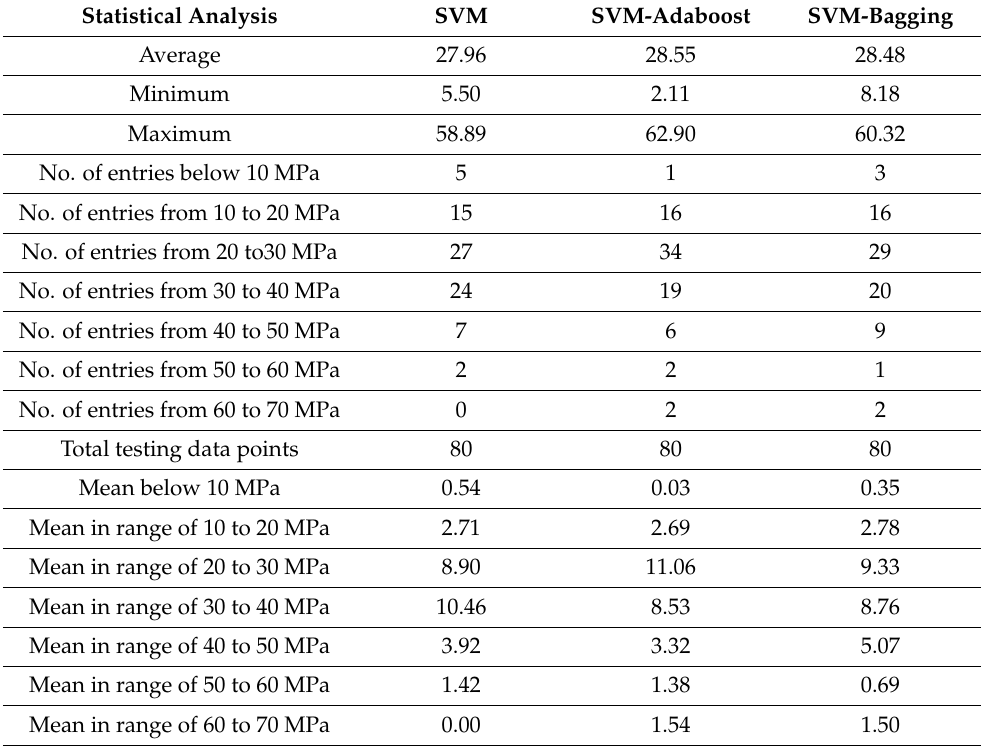
Table 13. Statistical analysis of compressive strength SVM